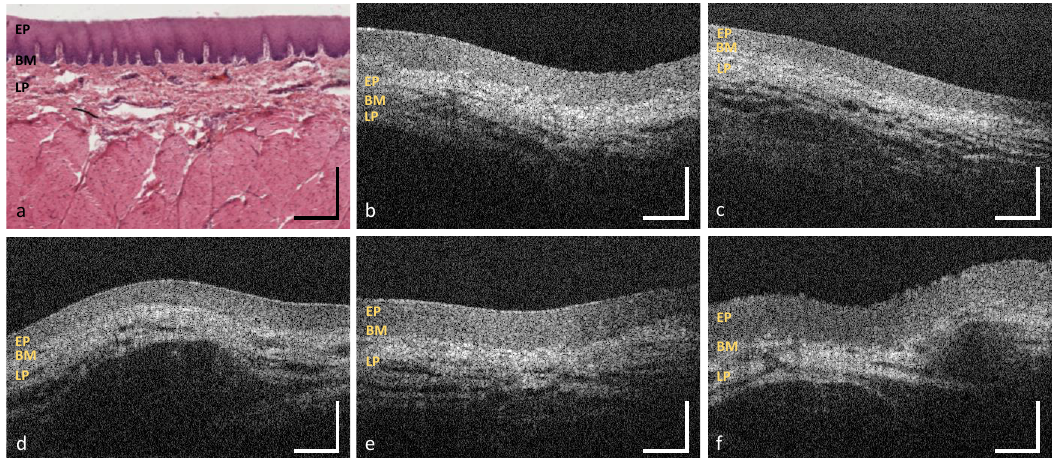
Figure 9. OCT images of the ventral tongue ( b , c ) and the mouth floor (MP11) ( d – f ). The sample pictures represent the anterior (MP9) ( b ) and posterior sublingual region (MP10) ( c ). Exemplary HE stained histological cross sections depicting the sublingual mucosa ( a ) ([44] modified). EP: epithelium, BM: basement membrane, LP: lamina propria. Scale bars: 200 µ